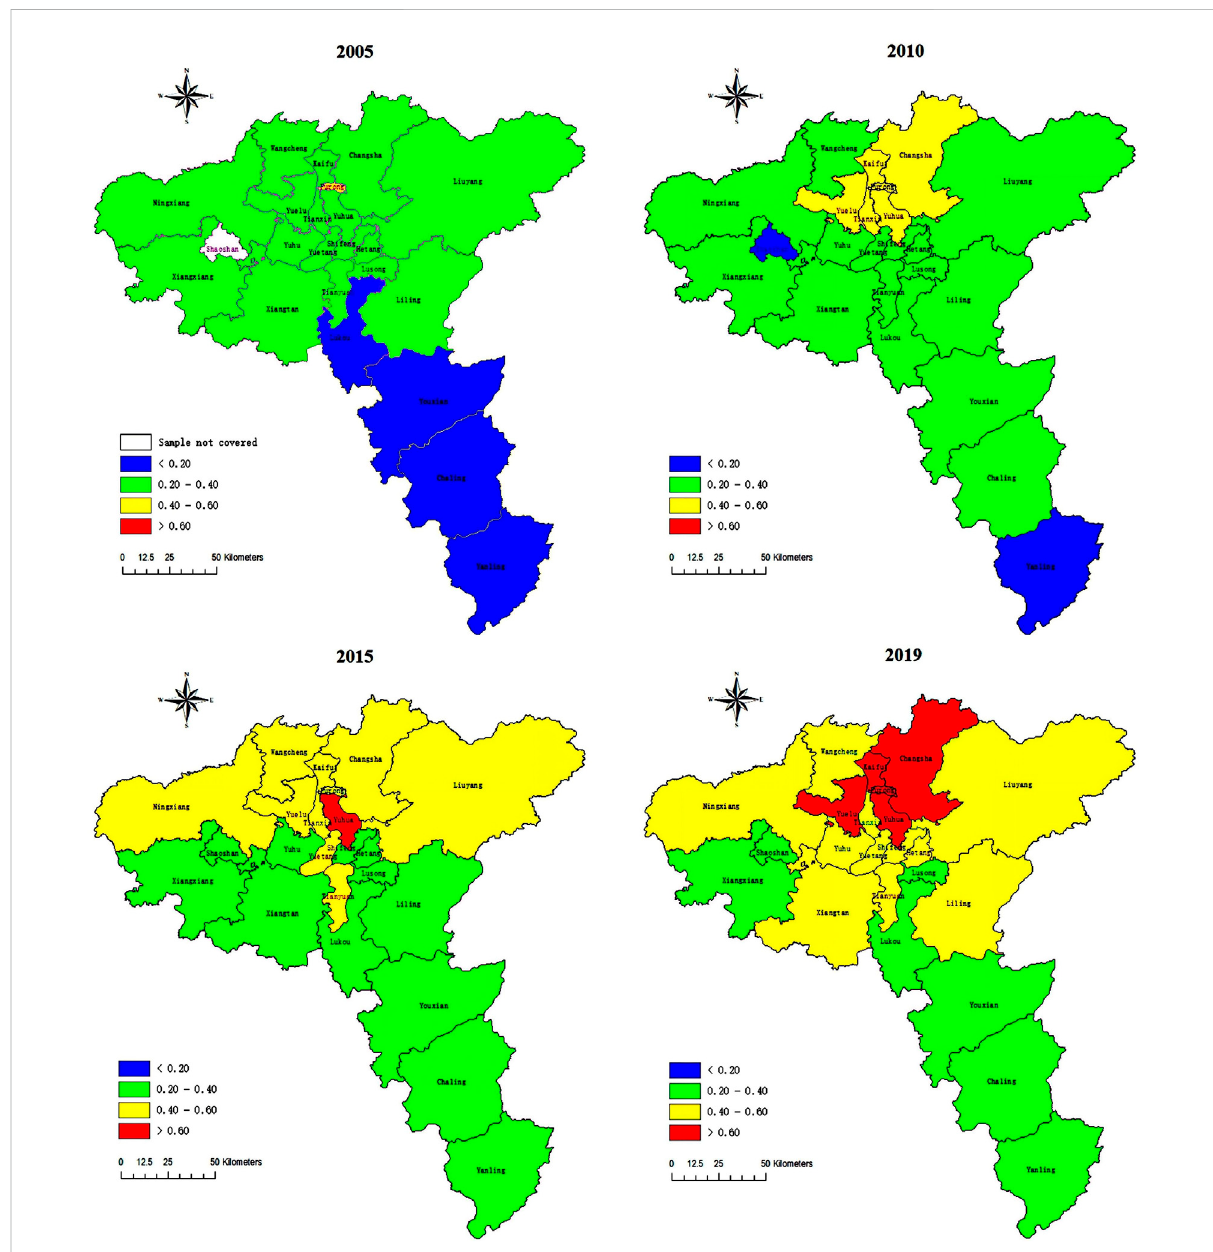
FIGURE 4 Spatial evolution trend of population spatial